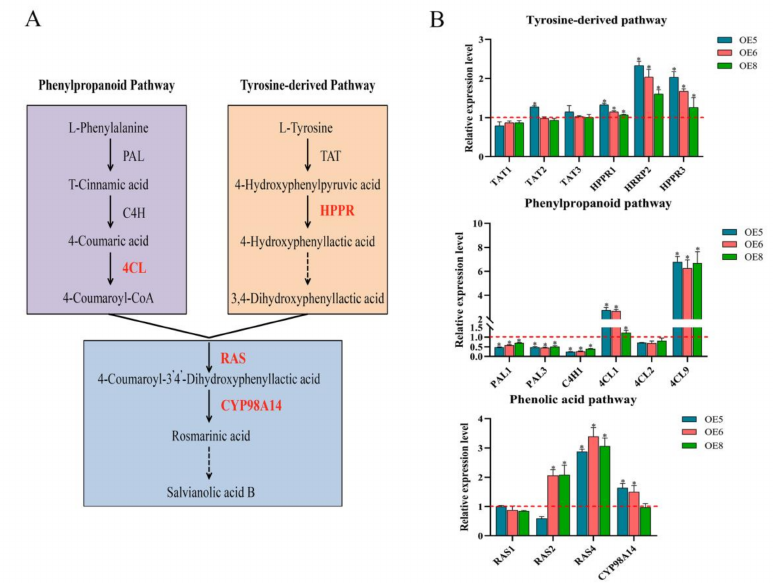
Figure 7. Expression changes of enzyme genes for the phenolic acid biosynthetic pathway in the SmSPL6 -overexpressed (OE) transgenic lines. ( A ) Proposed biosynthetic pathway for phenolic acids (red indicates genes activated by Sm SPL6). TAT, tyrosine aminotransferase; HPPR, hydroxyl phenylpyruvate reductase; PAL, phenylalanine ammonia lyase; C4H, cinnamate 4-hydroxylase; 4CL, hydroxycinnamate-CoA ligase; RAS, rosmarinic acid synthase; and CYP, cytochrome P450 enzymes. ( B ) Expression changes of enzyme genes for the tyrosine pathway, phenylpropanoid pathway, and specific phenolic acid pathway in the SmSPL6 -OE lines. The expression level in the control was set to 1 (shown as red dotted lines). All data are the means of three biological replicates, with error bars indicating SD; * represents a significant difference at p < 0.05 compared with the control.